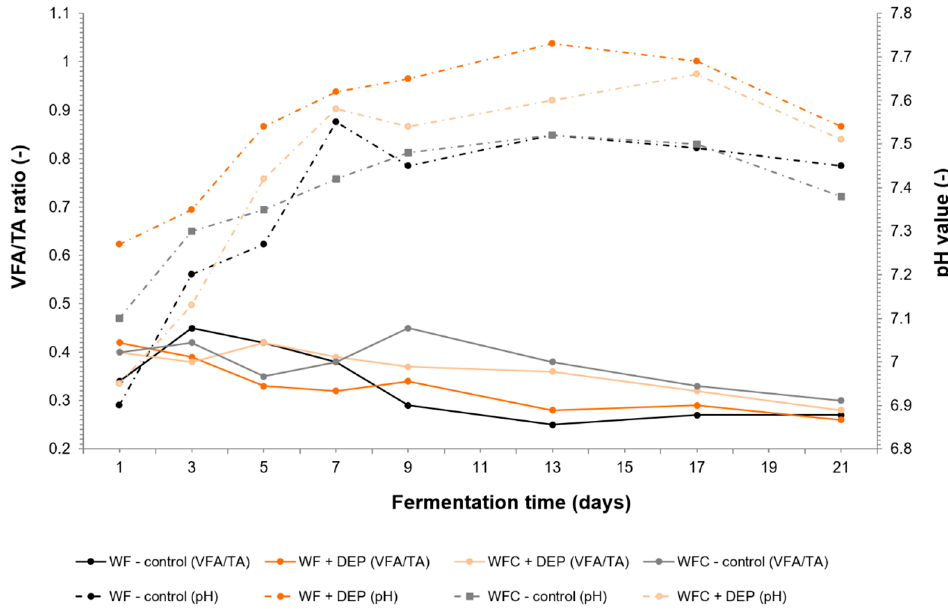
Figure 5. Variation in the pH and VFA/TA in the WF-control, WF + DEP, WFC-control, and WFC + DEP samples.